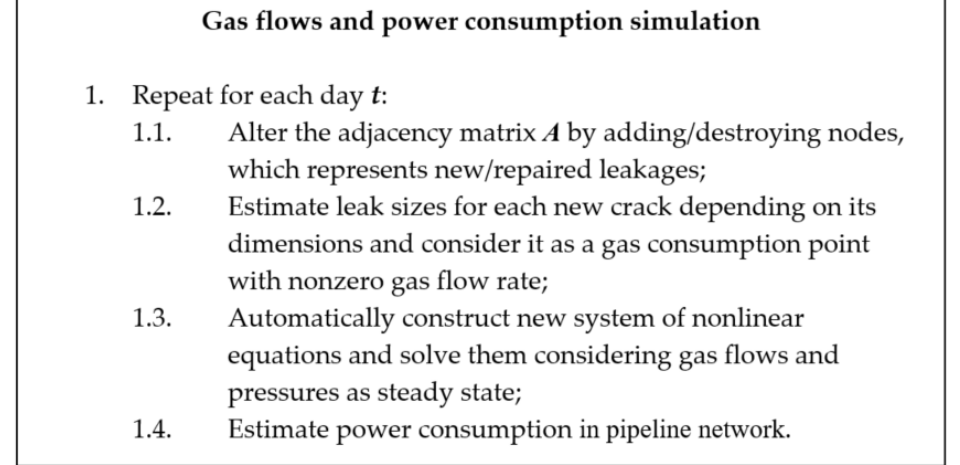
Figure 2. High-level algorithm for gas flows and power consumption in the network simulation.